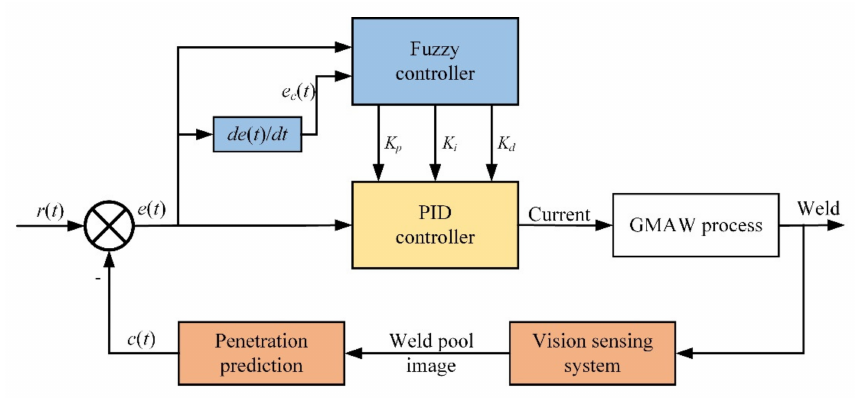
Figure 6. Block diagram of fuzzy PID controller.